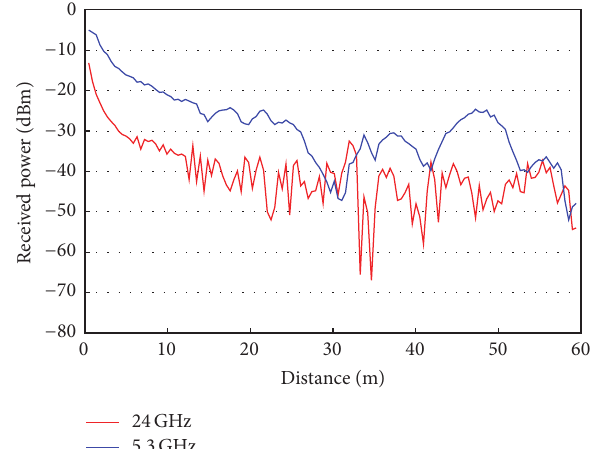
Figure 7: Received power levels of 24 GHz and 5.3GHz signals with the receiver moved from the transmitter to the right end of the corridor.